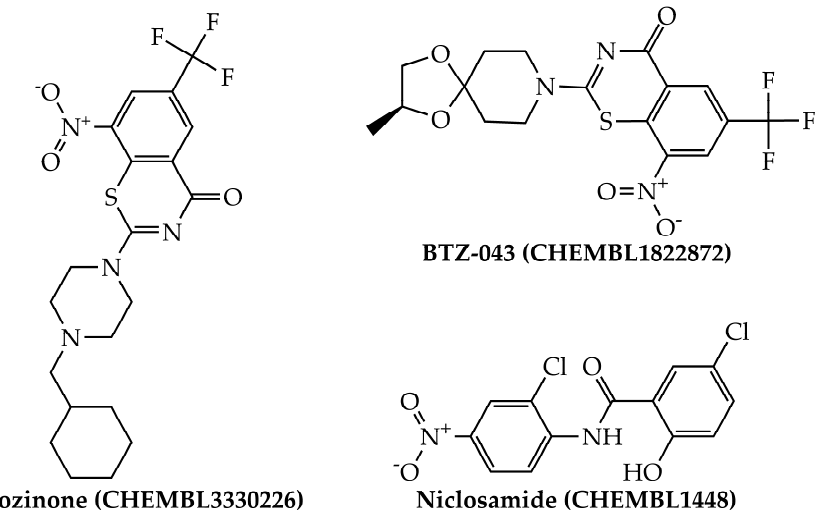
Figure 4. Structures of the agency-regulated chemicals with a proven anti-TB activity identified by the mtc-QSAR-EL